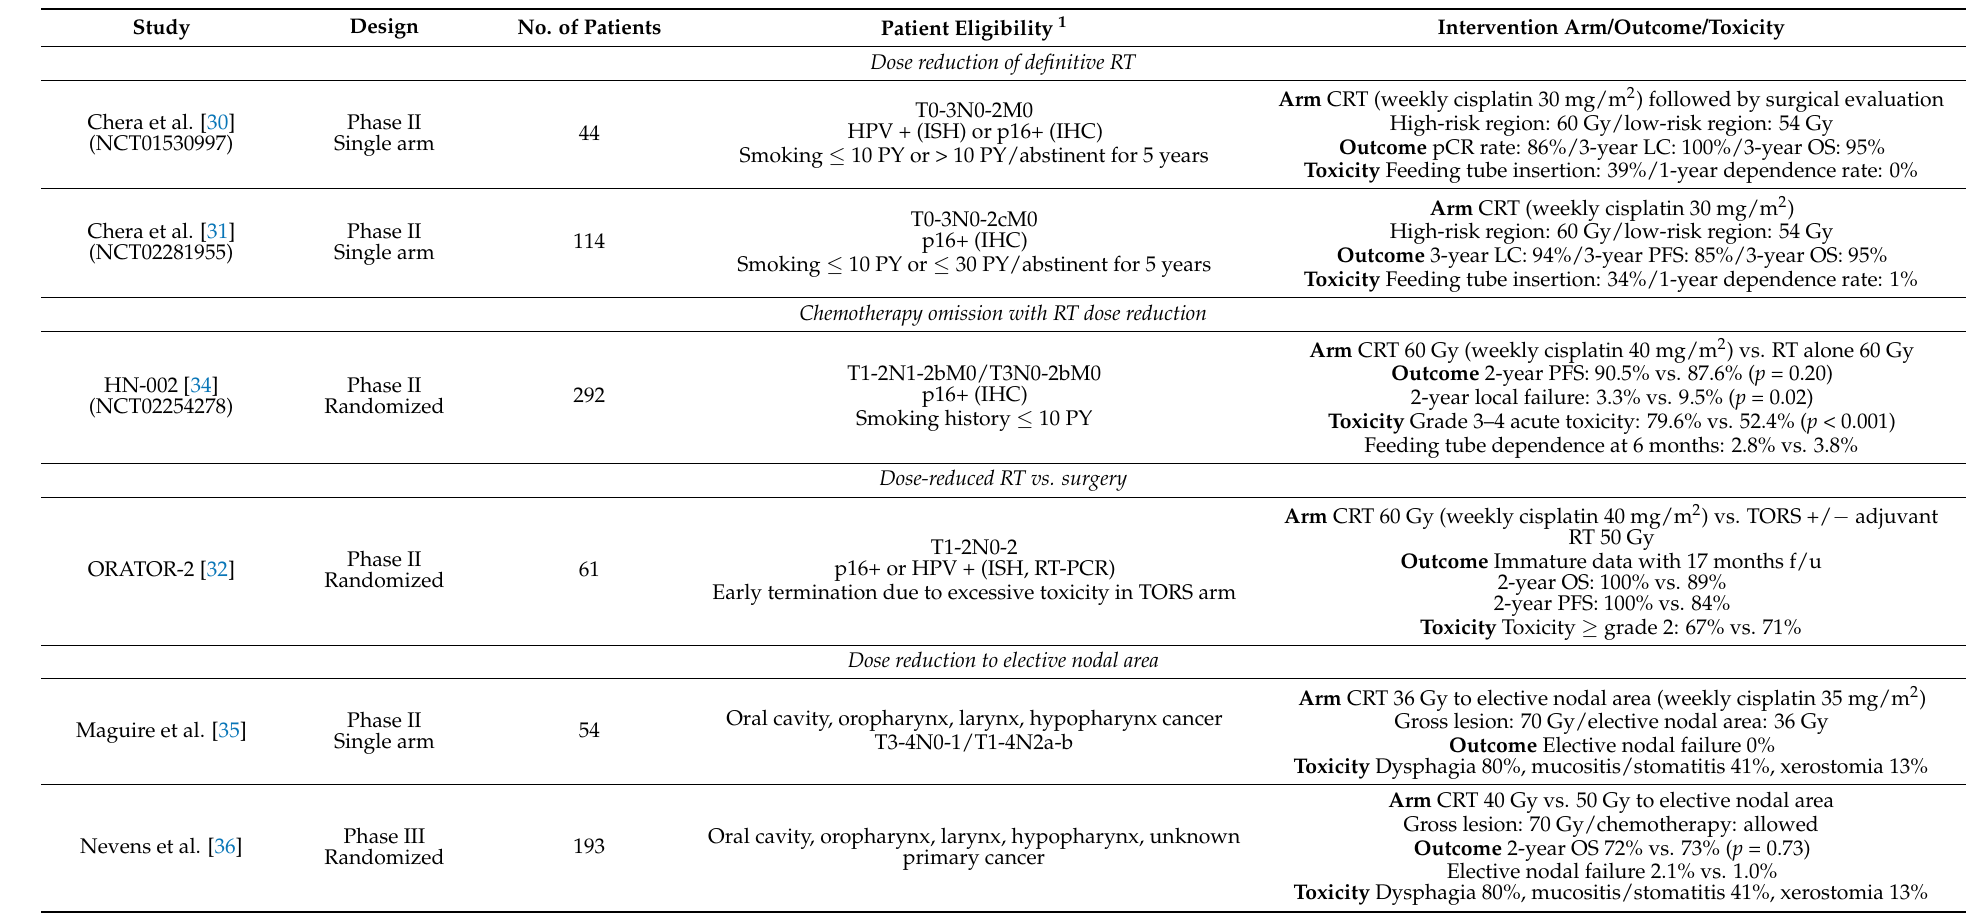
Table 1. Deintensification trials in a definitive